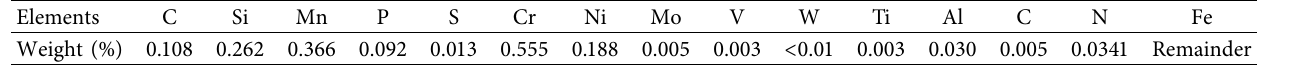
Table 1: Chemical composition of corten steel (conforming to ASTM 242).